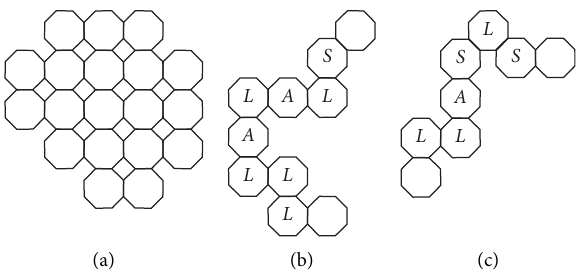
Figure 1: Three octagonal graphs: (a) G